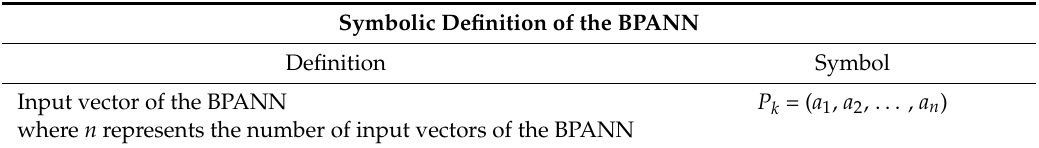
Table A1. Learning process of the